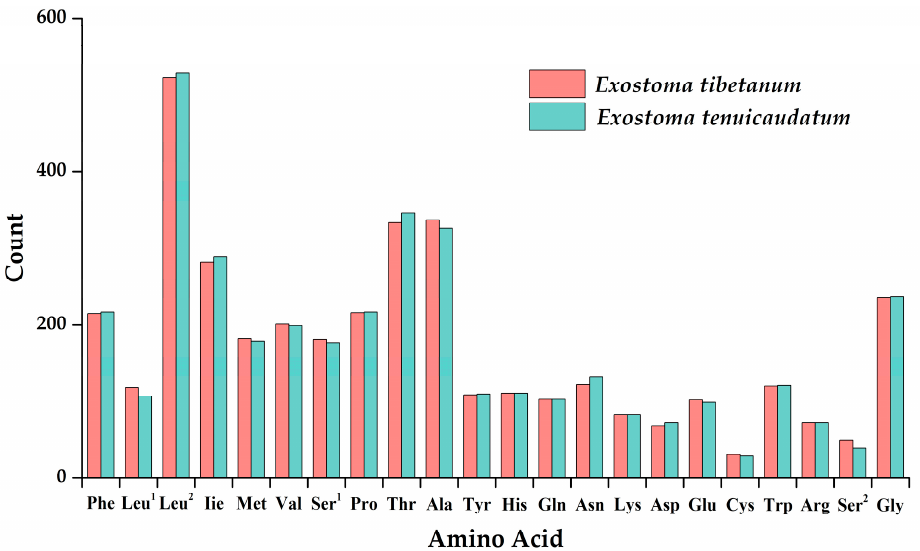
Figure 2. Amino acid frequency in the protein-coding genes of Exostoma tibetanum and Exostoma tenuicaudatum .